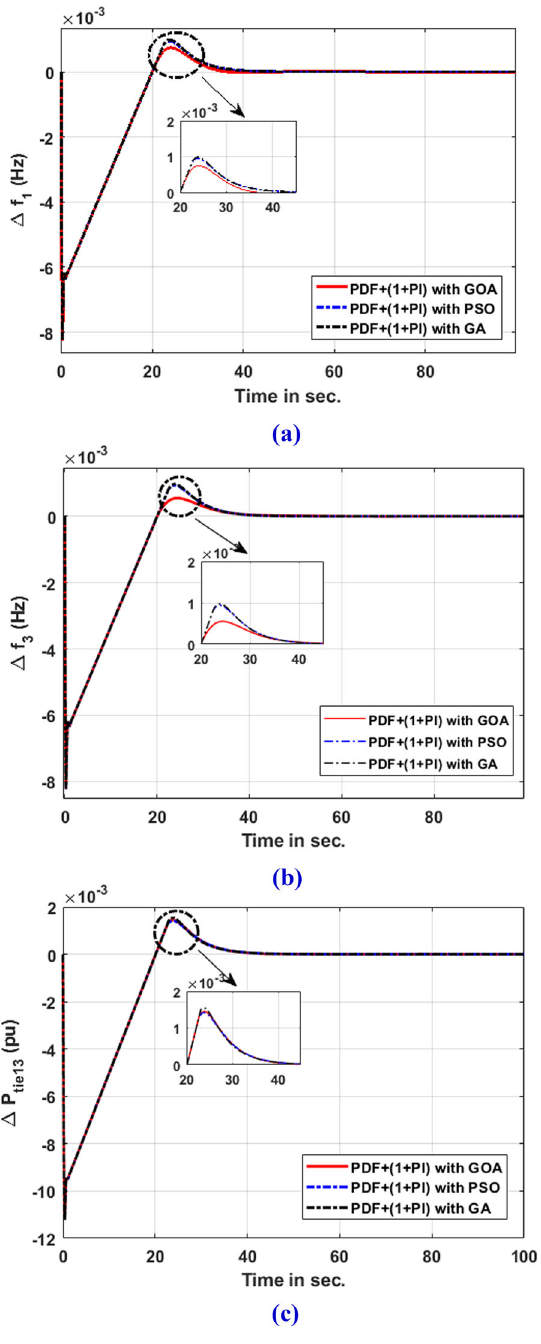
Fig. 8 Dynamic responses of different techniques of GOA, PSO and GA optimized with PDF plus (1 + PI), with 1% SLP and IPFC device in each